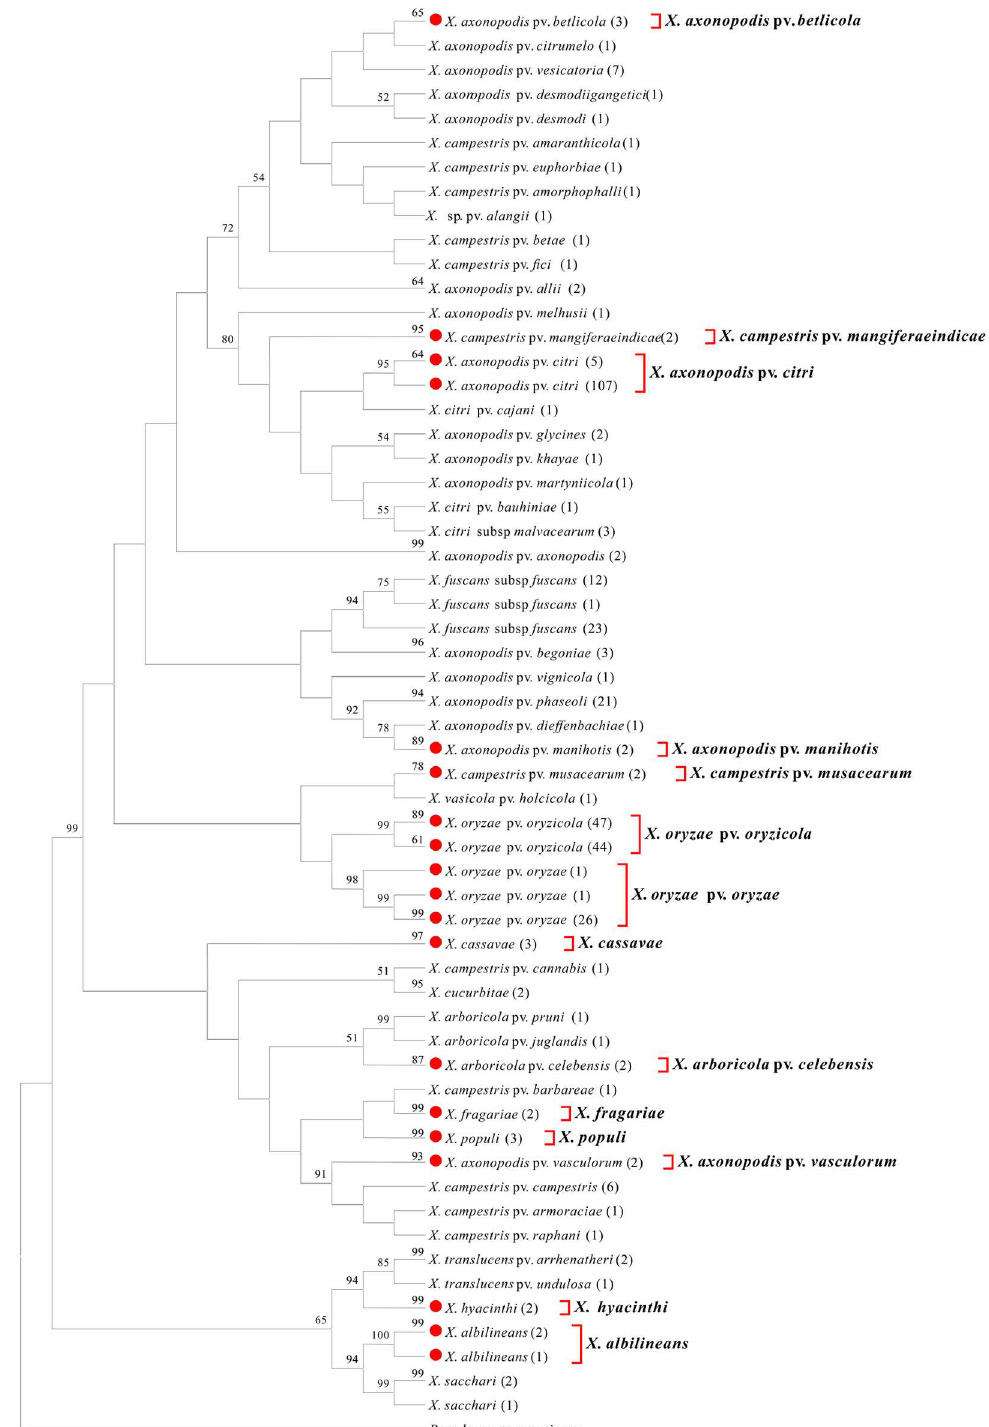
Fig 4. Neighbor-joining tree based on cpn60 . Bootstrap values ( > 50%)are shown abovethe branches. Identical sequencesare representedonly once. Numbers followingtaxon names indicate the numberof isolates. Red dots indicatequarantine Xanthomonas species/pathovars. Species/pathovars that were successfully identifiedare shown on the